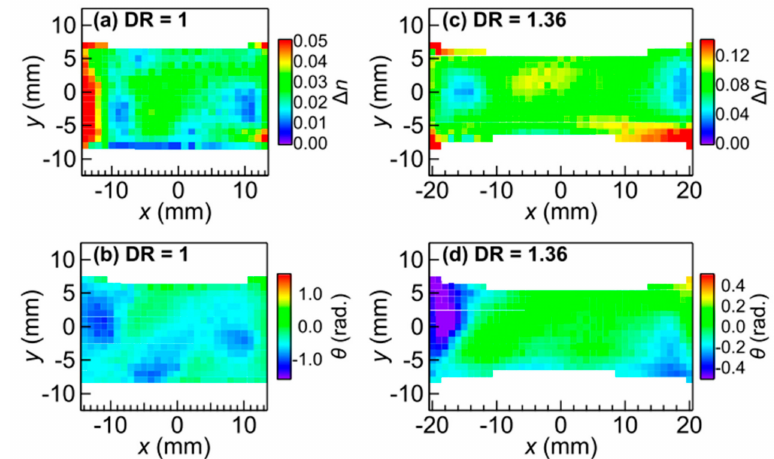
Figure 9. Spatial map of the change in refractive index ( ∆ n) and the slow optical axis ( θ ) with respect to the x -axis for a black rubber sample under normal condition versus stretched to 1.36 times (DR = 1.36) its length in the x -axis: ( a , b ) ∆ n is mostly around 0.03, and θ is mostly random; ( c , d ) ∆ n peaks in the centre where it has been stretched the most, and θ has become uniformly zero in the centre. Reproduced with permission from